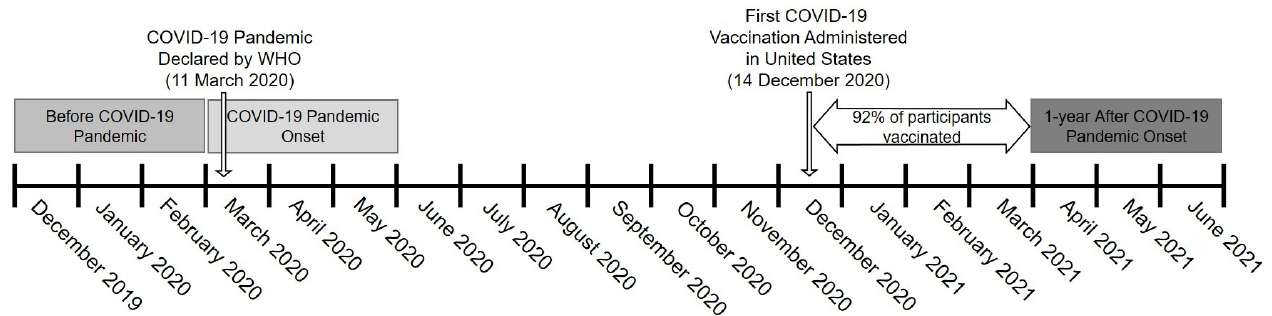
Figure 1. Study design depicting three different data-collection time points for physical activity and sedentary behavior. WHO, World Health Organization.